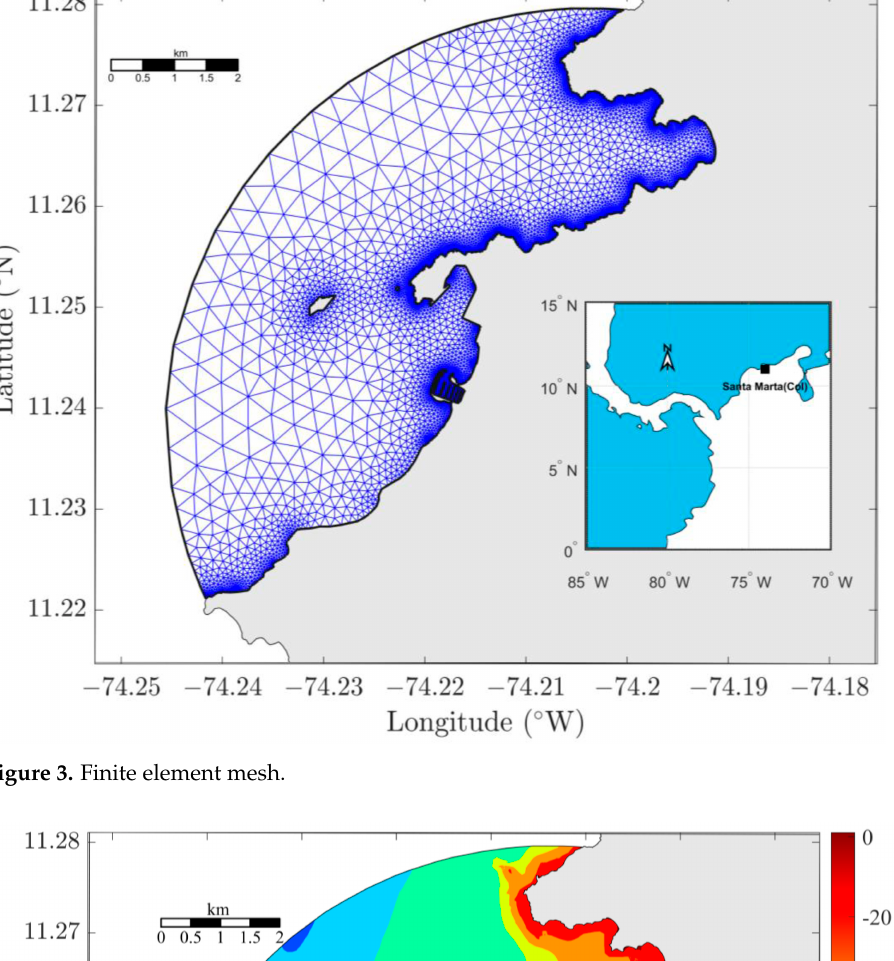
Figure 3. Finite element mesh.